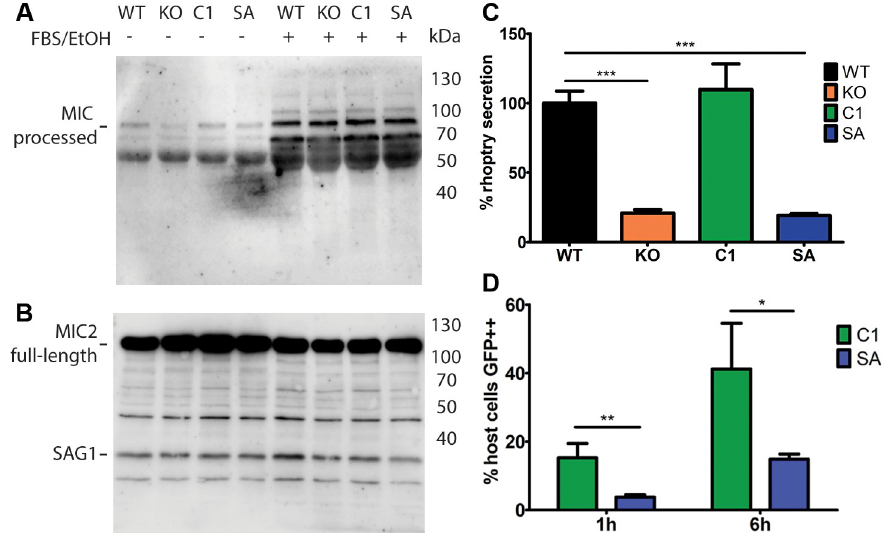
Fig 5. TgPL3 enhances rhoptry but not microneme secretion. Excreted/secreted antigen (ESA) was induced in 1 x 10 8 parasites by the addition of 3% fetal bovine serum and 1% ethanol (FBS/EtOH). Supernatant (A) and pellet (B) were run on a 12% SDS-page gel, transferred to PVDF membranes and simultaneously probed with rabbit anti-MIC2 and mouse anti-SAG (monoclonal DG52). (A) Western blotting showing processed MIC-2 (95–100 kDa) and no SAG1. Size markers are indicated on the right side in kDa. (B) Pellet or loading control shows the full-size MIC-2 band (115 kDa) and a lower band corresponding to SAG1 (30 kDa). (C) Quantification of rhoptry discharge during e- vacuole formation. Triplicate monolayers of HFFs were infected with 5x10 6 parasites that were pre-treated with cytochalasin D. After a 15-minute incubation, the parasites were stained with a mouse α -SAG1 antibody and a rabbit α -ROP1 antibody. After counting, percent rhoptry secretion was normalized to the WT strain. Three independent experiments were performed, and the combined results are shown here. ��� p < 0.001 (D) Rhoptry secretion by the SeCreEt assay [28] and the number of GFP++ host cells was quantified by FACS analysis, as shown on the y-axis. After 1 hour of invasion, Δ TgPL3 parasites complemented with S1409A showed a significant difference in rhoptry secretion compared to parasites complemented with the WT gene ( �� p < 0.01). After 6 hours, this difference was less significant ( � p < 0.05). Shown here the results from one of two independent experiments performed in